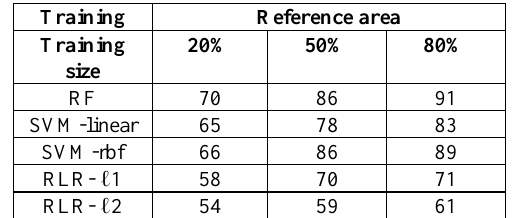
Table 7 . Mean overall accuracy obtained during